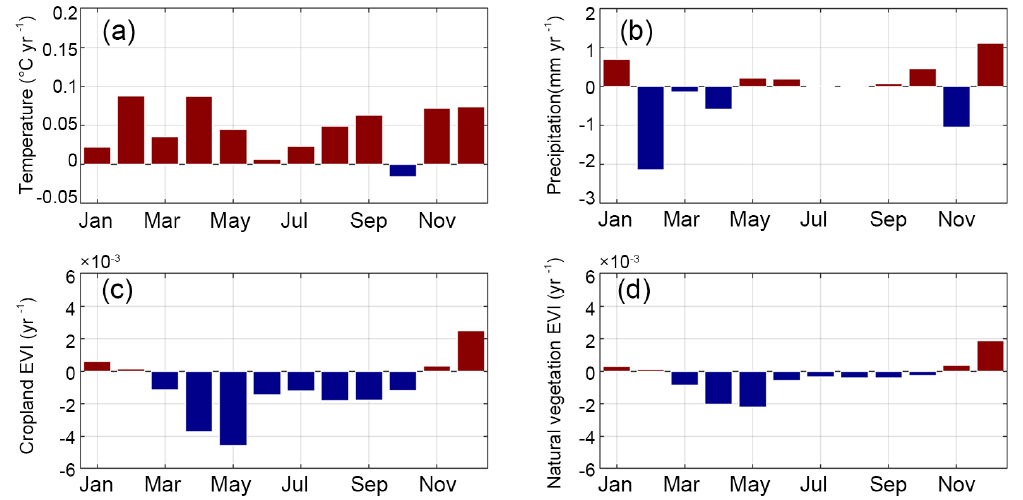
Figure 4. Interannual trends during 2001–2018 for each month of (a) temperature, (b) precipitation, (c) cropland EVI and (d) natural vegetation EVI.